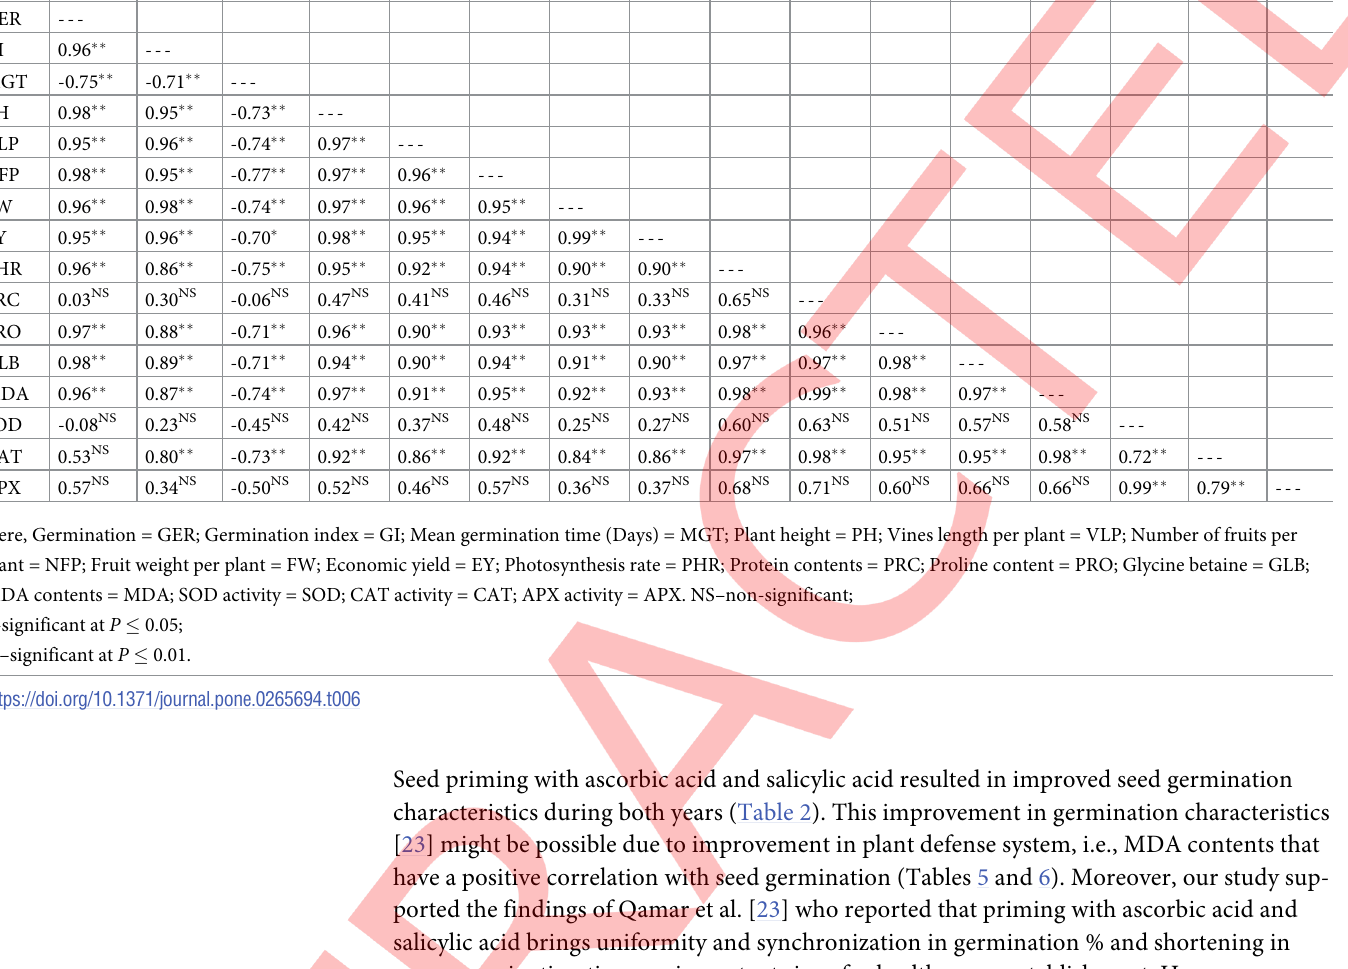
Table 6. Pearson ´s correlation among different growth, yield, and biochemical attributes of Indian squash during 2020. GER GI